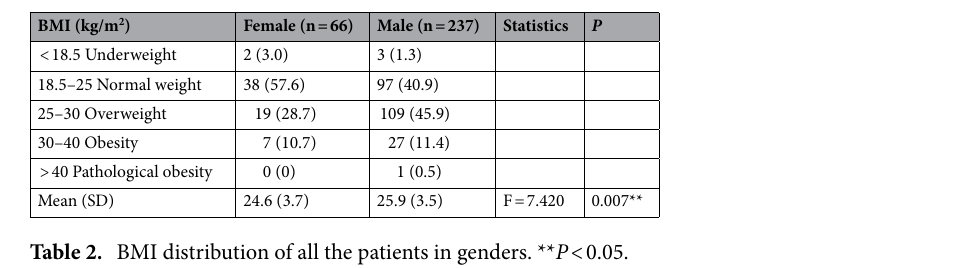
Table 2. BMI distribution of all the patients in genders. ** P < 0.05.